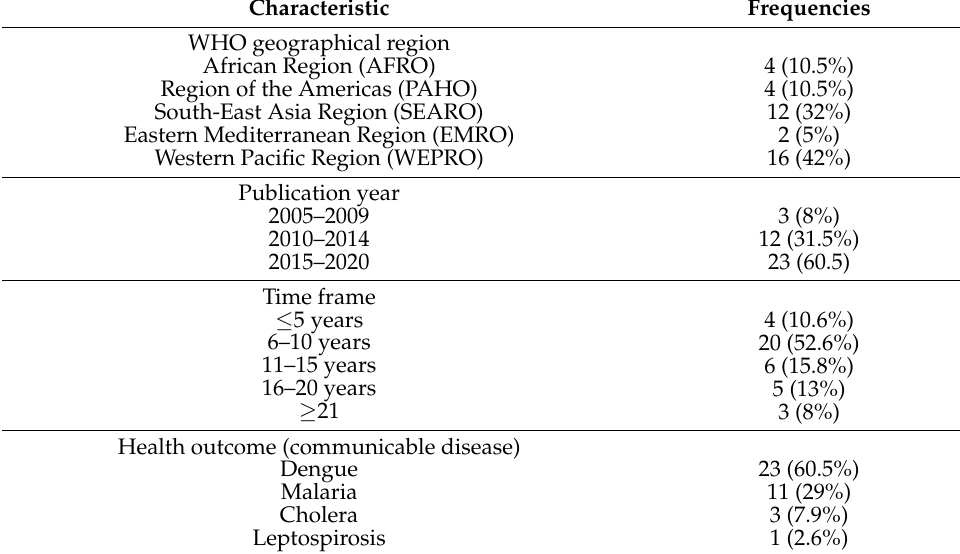
Table 1. Descriptive summary of included studies ( n =